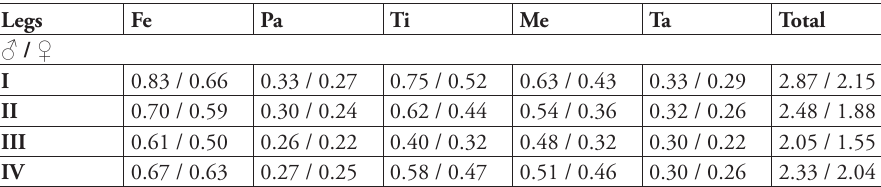
Table 1. Leg measurements of Lathys ankaraensis sp.